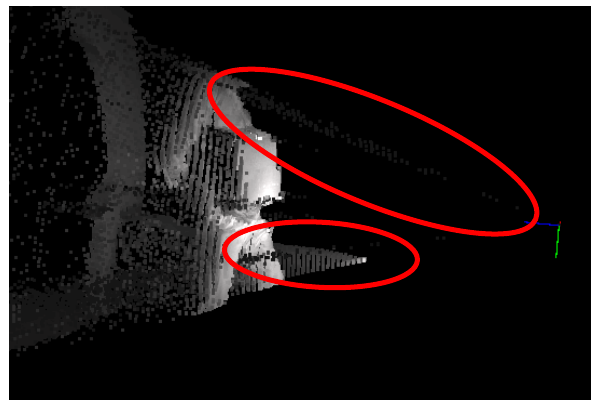
Figure 7. 3d points from depth image with NIR intensity. The red ellipses show areas with wrong depth estimation caused by low reflection intensities (upper case) or depth jumps (lower case).